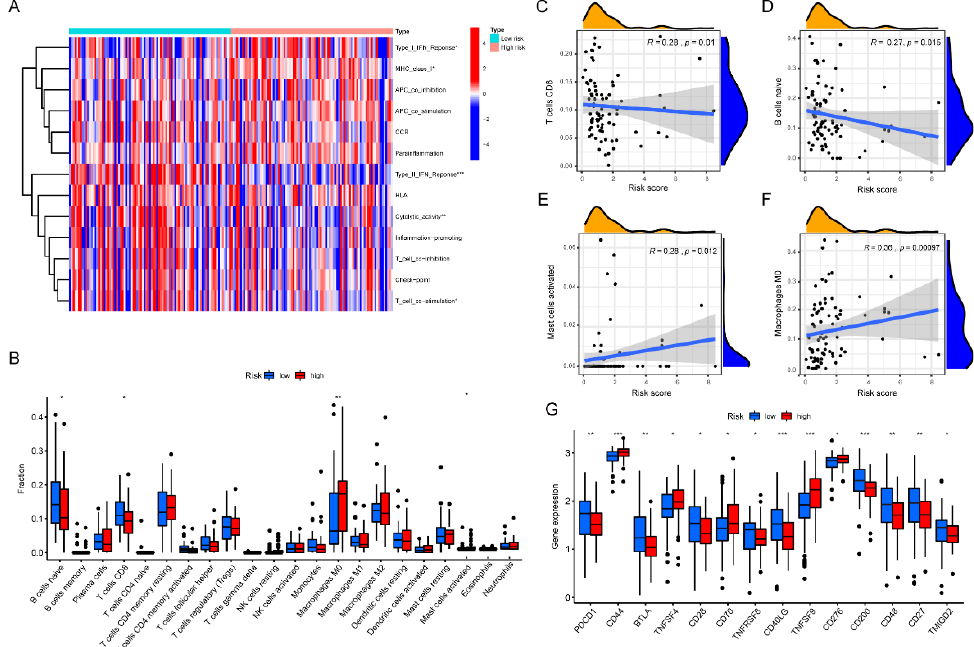
Figure 8. Correlation of Risk Prognostic Signature and Tumor Immune Microenvironment. ( A ) Differences in immune function between the high- and low-risk groups; ( B ) Differences in the proportions of different immune cells in the high- and low-risk groups; ( C – F ) Correlation between risk scores and key immune cells; ( G ) Differences in the expression of key molecules of immune checkpoints between the high- and low-risk groups. * p < 0.05, ** p < 0.01, *** p < 0.001.